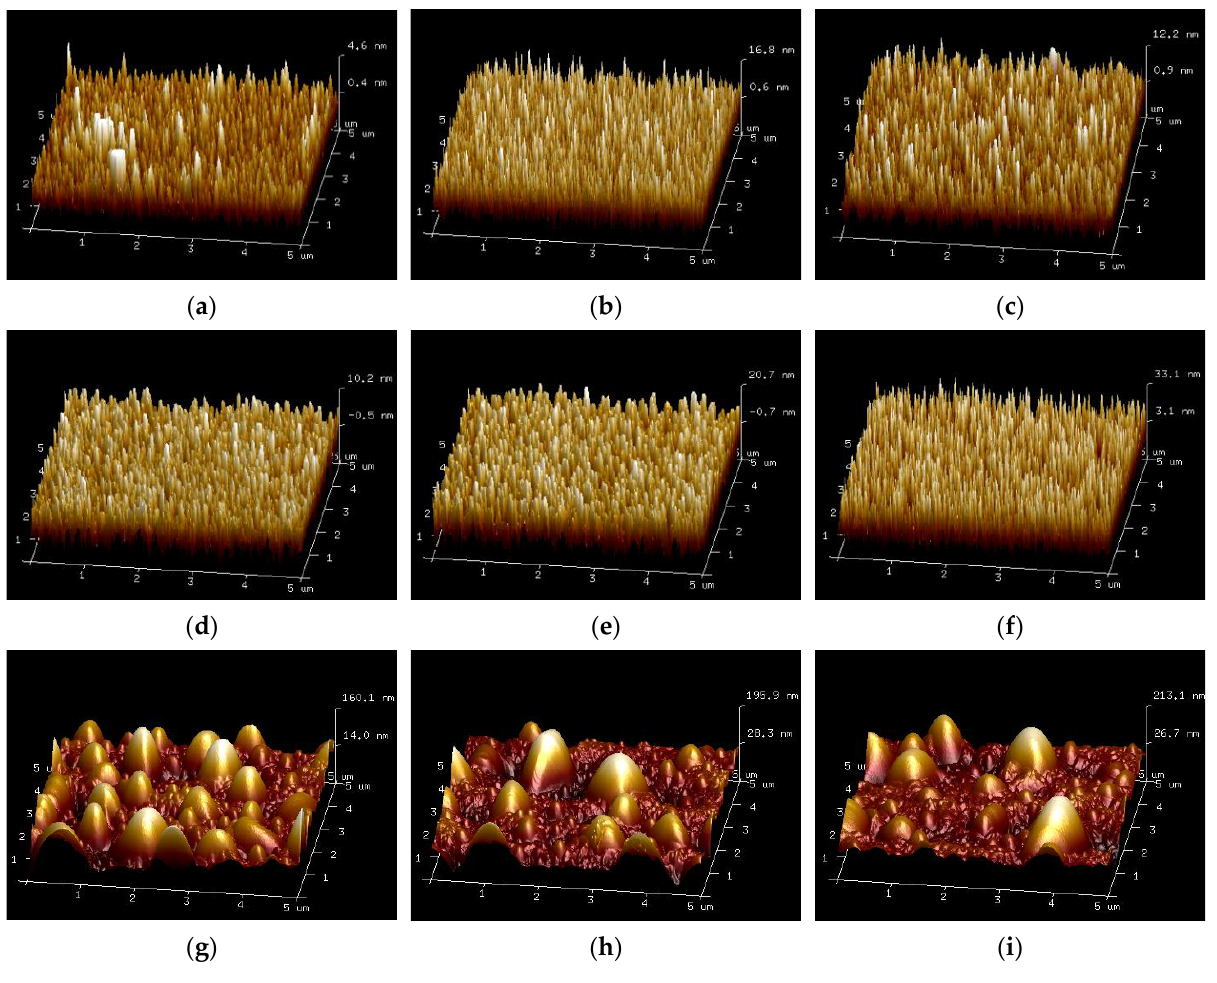
Figure 4. AFM images were obtained from the Ge buffer layer and Ge 1-x Sn x samples at different deposition temperatures: ( a ) Ge Buffer; ( b ) Ge 1-x Sn x deposited at 180 °C; ( c ) Ge 1-x Sn x deposited at 200 °C; ( d ) Ge 1-x Sn x deposited at 225 °C; ( e ) Ge 1-x Sn x deposited at 240 °C; ( f ) Ge 1-x Sn x deposited at 250 °C; ( g ) Ge 1-x Sn x deposited at 260 °C; ( h ) Ge 1-x Sn x deposited at 275 °C; ( i ) Ge 1-x Sn x deposited at 300 °C.